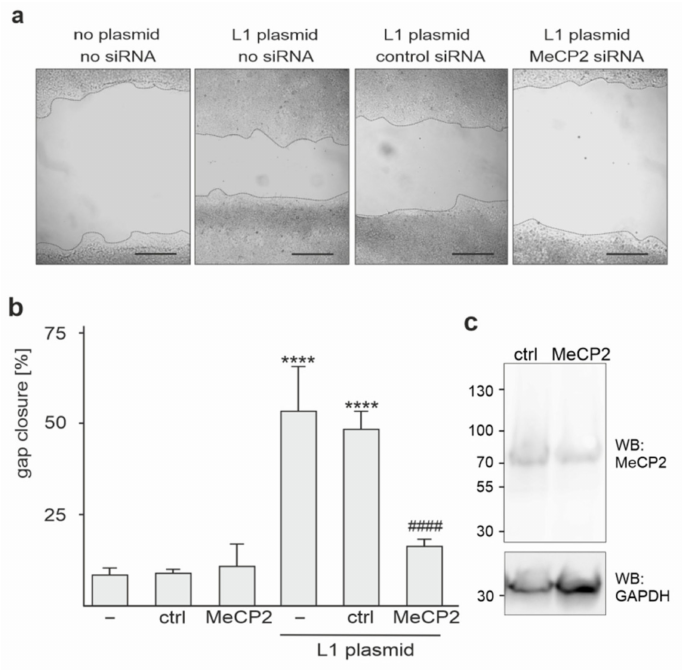
Figure 4. MeCP2 contributes to L1-dependent migration of HEK293 cells. ( a – c ) HEK293 cells were transfected without ( − ) or with control siRNA (ctrl) or MeCP2 siRNA alone, or with L1- encoding plasmid alone or together with control or MeCP2 siRNA. After 24 h transfected cells were subjected to a scratch wound assay, and the extent of gap closure was determined after further 24 h. ( a ) Representative images are shown for scratch wounds with dotted lines outlining the gaps. Scale bars: 100 µ m. ( b ) Mean values + SD from three experiments carried out in duplicates are shown for gap closure, which was calculated as a ratio of the gap size 24 h after scratch injury and the gap size immediately after scratch injury (set to 100%) (**** p < 0.001 relative to mock-transfected cells, #### p < 0.001 relative to the L1-expressing cells not co-transfected with siRNAs; one-way ANOVA with Dunn’s multiple comparison test). ( c ) Western blot analysis of lysates from cells co-transfected with L1 plasmid and control siRNA or MeCP2